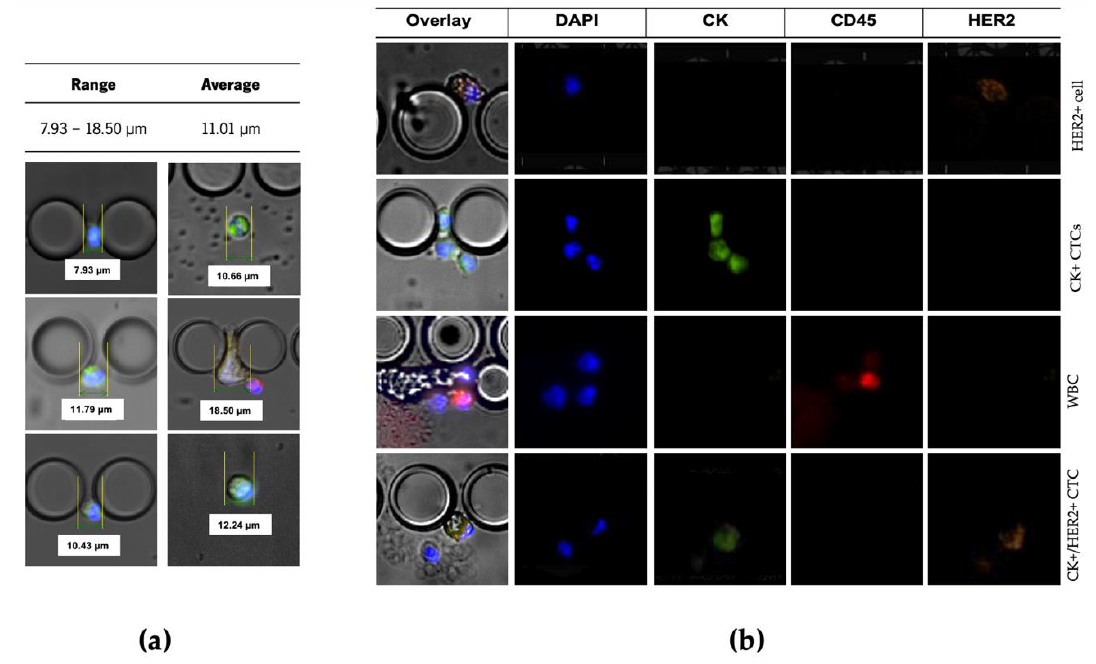
Figure 4. ( a ) Representative image of CTCs trapped inside the RUBYchip TM . Size was estimated using measurements of different patient samples. CTCs size range is from 7.93 µ m up to 18.50 µ m. ( b ) Representative image of the different types of cells trapped inside the chip. Isolated cells trapped between pillars of the chip were stained with Anti-Cytokeratin pan-FITC, Cyanin5 Anti-Human CD45, DyLight 550 Anti-ErbB2/HER2, and the nuclear marker DAPI. First, a DAPI+/CK−/CD45−/HER2+ captured cell is shown. In the second line, three captured CK+ CTCs are represented, DAPI+/CK+/CD45−/HER2−. The third line shows a white blood cells, DAPI+/CK−/CD45+/HER2−. Finally, a DAPI+/CK+/CD45−/HER2+ is shown. The images were acquired and observed with a 20× objective.